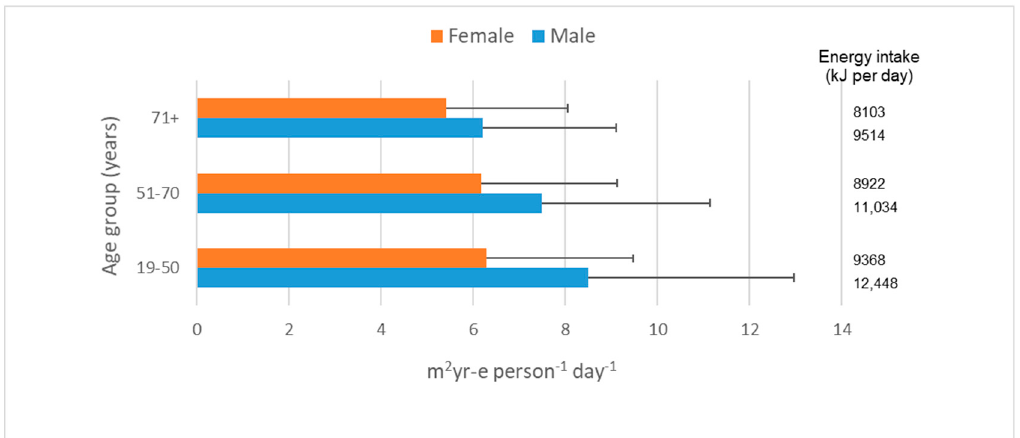
Figure 1. This cropland scarcity footprint of Australian adult diets based on 9341 individual daily diets reported in the Australian Health Survey. Error bars indicate the standard deviation.